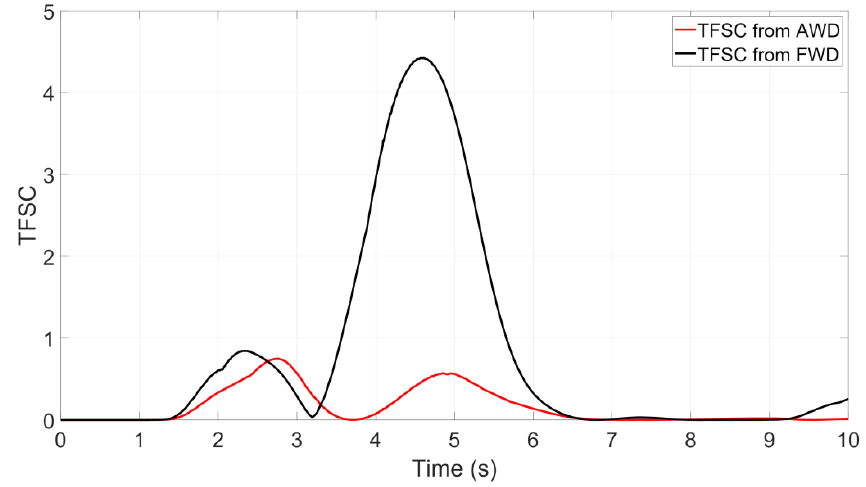
Figure 16. TFSC comparison results between an AWD vehicle with stability control and a FWD vehicle without stability control for the same steering input.